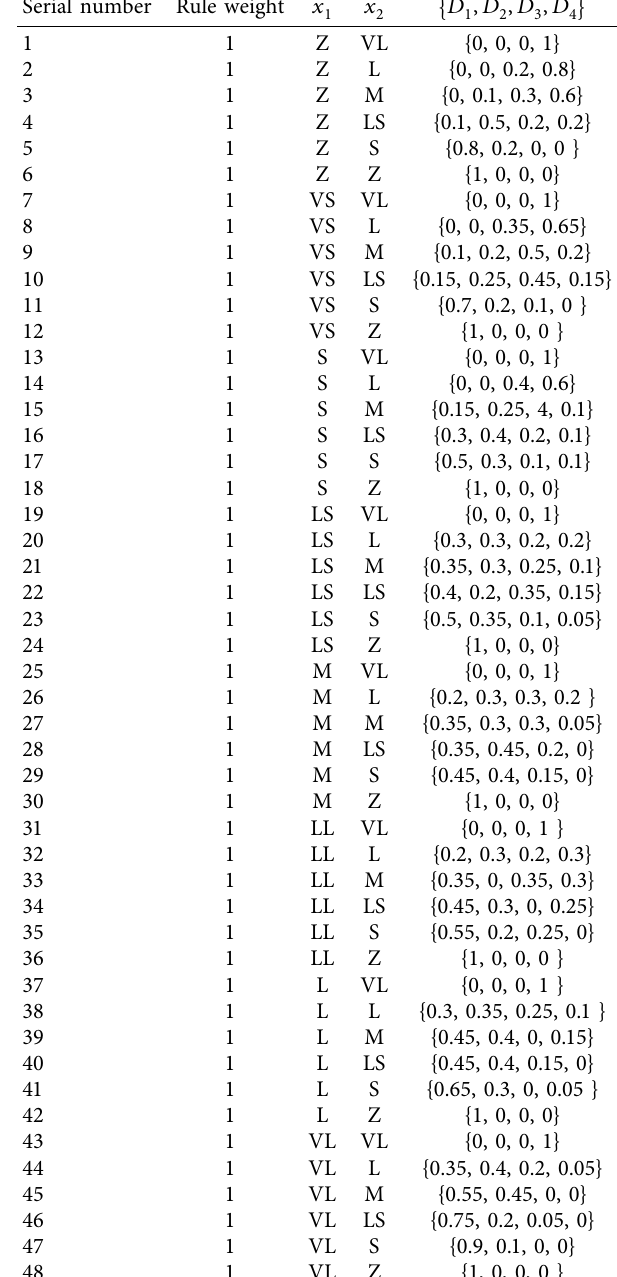
Table 4: Belief rule